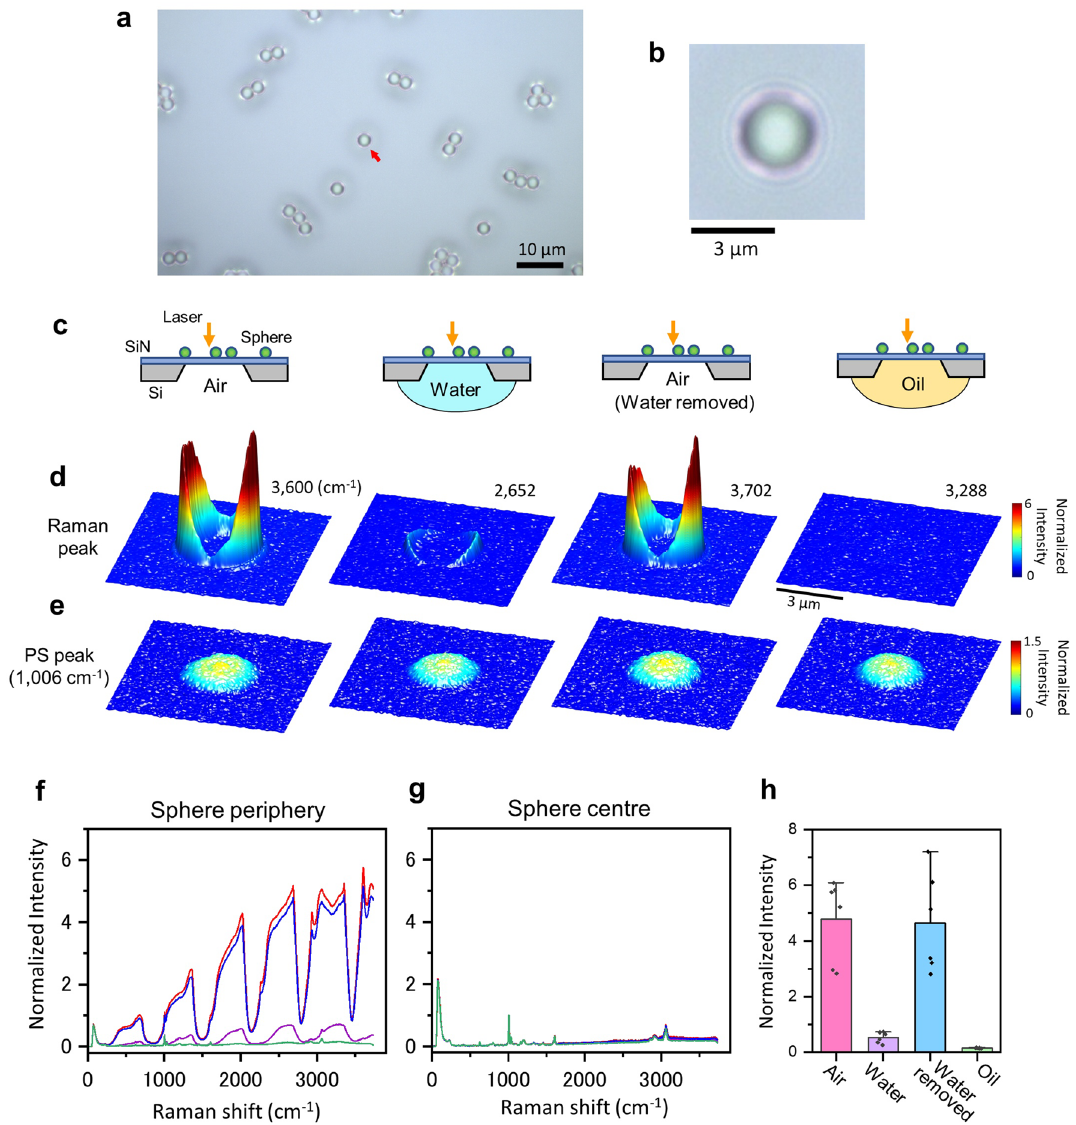
Figure 4. Raman spectrum of PS microspheres on the SiN film with water or oil underneath the film instead of air. ( a ) An OM image of 3 μm diameter PS spheres on the 50 nm thick SiN film. ( b ) Magnified sphere image indicated by a red arrow in ( a ). ( c ) Schematic of the measurement of Raman spectrum of 3 μm diameter PS spheres on a SiN film with water or immersion oil underneath the film. ( d ) Pseudo-3D colour maps of the anomalous Raman peaks on a SiN film with water or oil underneath the film. ( e ) Pseudo-3D colour maps of PS Raman peaks on a SiN film with water or oil underneath of the film. The sphere structures were observed in all the cases. ( f ) Raman spectra of sphere peripheries normalized by PS peaks of 1006 cm −1 of the sphere centre on a SiN film with air, water or oil underneath the film. The anomalous periodic Raman spectra are seen with the air underneath the film (red, with air in ( c ) and ( d ) left and blue, with removal of water in ( c ) and ( d the third from the left). With water underneath the film, the anomalous Raman spectra decreased (purple, with water, in ( c ) and ( d ) the second from the left). With oil underneath the film, the Raman spectra indicated only the PS spectrum (green, with oil, in ( c ) and ( d ) right). ( g ) Normalized Raman spectra of sphere centre by PS peaks of 1006 cm −1 at the sphere centre on a SiN film with air, water or oil underneath the film. The Raman spectra under any condition show only the PS spectrum. ( h ) Relationship between the anomalous Raman peaks around the spheres and the SiN film with air, water or oil underneath the film. Six sphere samples were measured under each condition. The mean value of normalized intensity in each condition is 4.78 (air), 0.53 (water), 4.64 (water removed) and 0.15 (oil). Standard deviations are 1.48, 0.20, 1.79 and 0.02. Scale bars, 10 μm in ( a ), 3 μm in ( b ) and ( d